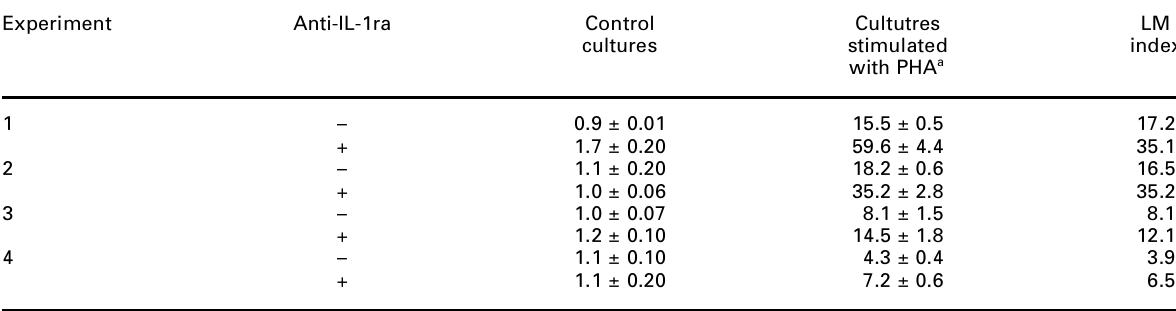
Table 4. Influence of anti-IL-1ra antibodies on [ 3 H]-thymidine incorporation (dpm ´ 10 3 ) in cultures stimulated with PHA at 24h of incubation